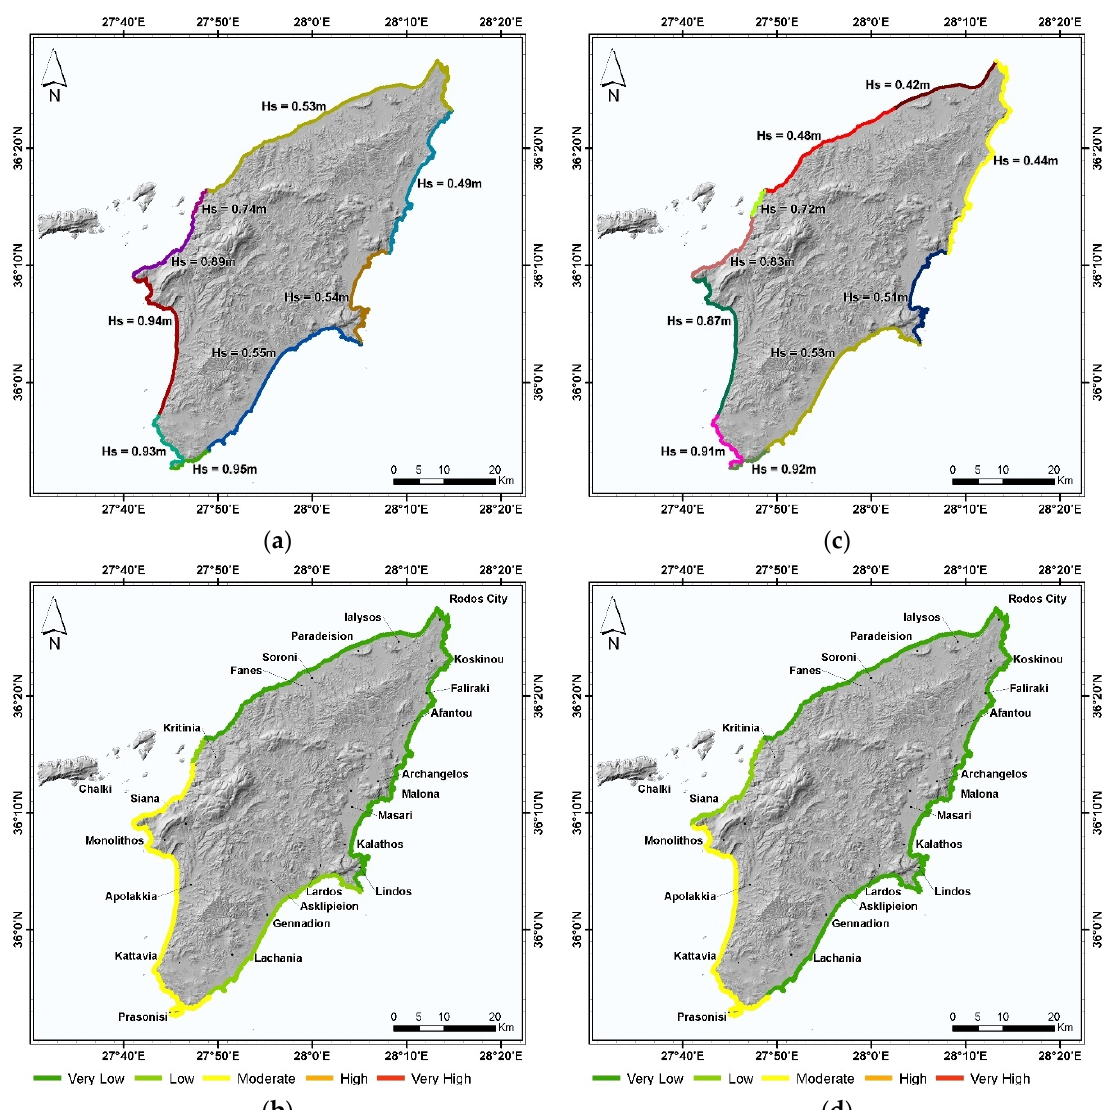
Figure 4. ( a , b ) Distribution of the current mean significant wave height (Hs) along the Rhodes Island coastline as well as evaluation of the relative vulnerability due to mean Hs. ( c , d ) Distribution of the projected to 2100 mean Hs along the Rhodes coastline as well as evaluation of the relative vulnerability due to mean Hs.